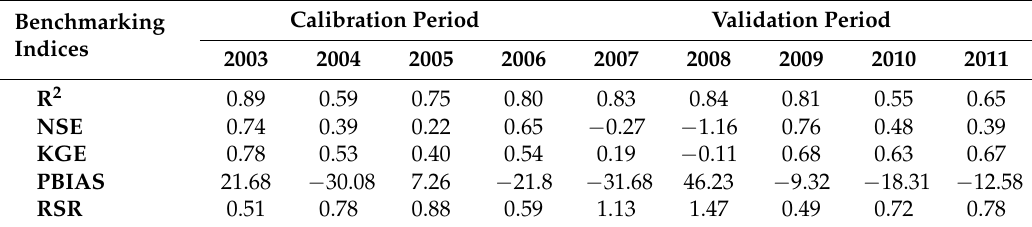
Table 2. Model performance rating results on annual basis.